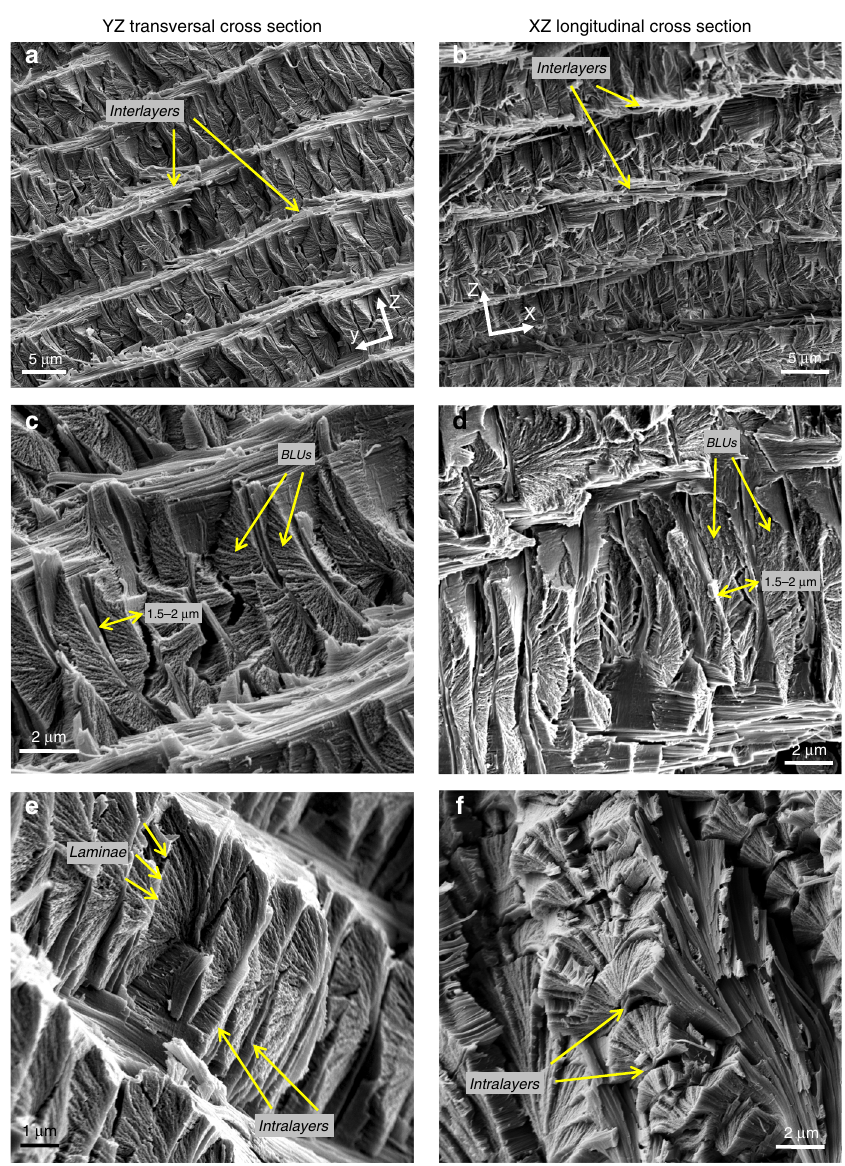
Fig. 2 SEM transversal and longitudinal cross-sections through BLU (Bouligand laminate unit) layers. a , b BLU layers and interlayers. c , d Individual BLUs and spatial period in x and y . e Intralayers between BLUs. f Oblique view of nested